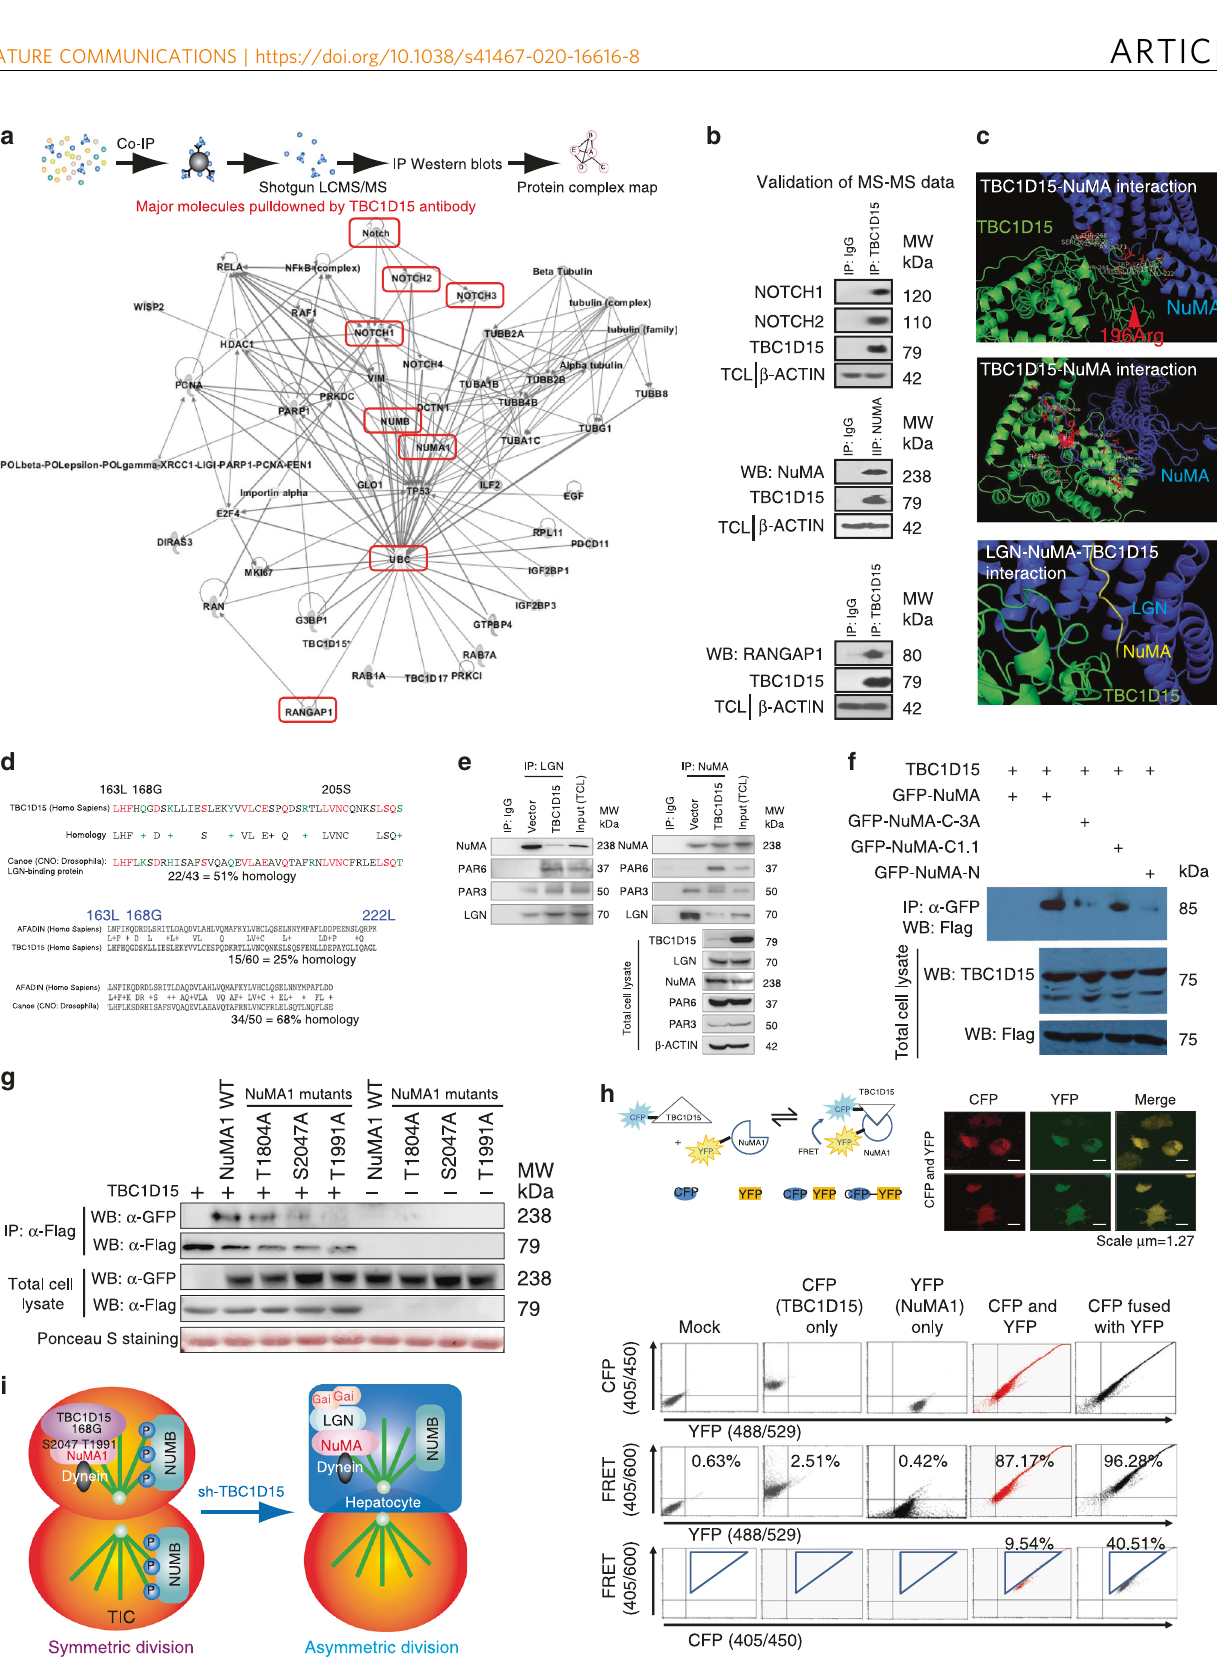
(Fig. 3b). The results clearly demonstrated the coordinated upregulation of NANOG, TBC1D15, N1ICD, and p-(S265) NUMB with p53 depletion in these patients. From this analysis, we concluded that TBC1D15 was an important mediator in two oncogenic pathways (loss of p53 and NOTCH